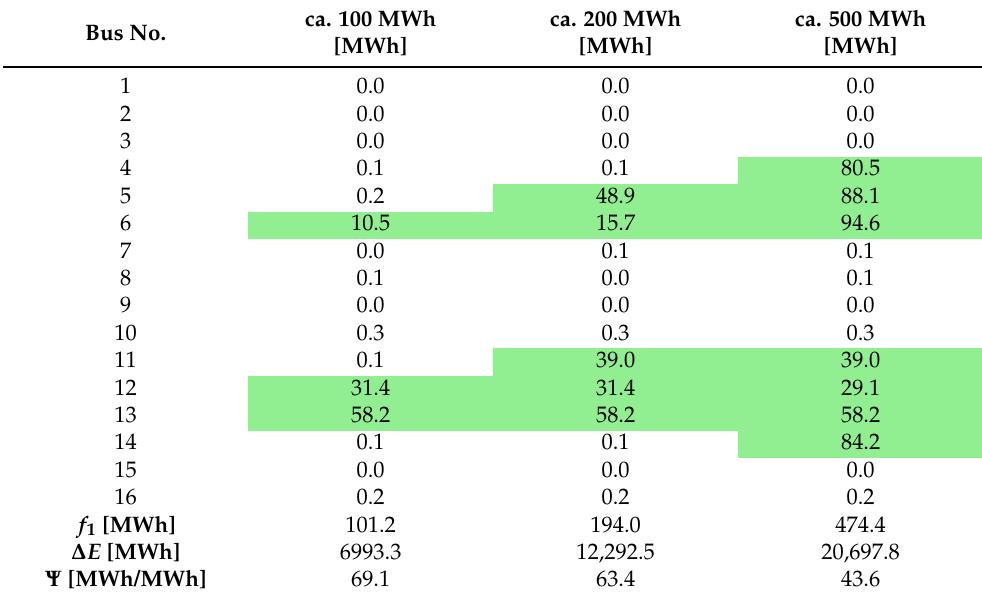
Table 5. Three solutions founded by pa (cid:101) -BRKGA with ca. 100 MWh, 200 MWh and 500 MWh of overall BESS capacity for Test Case